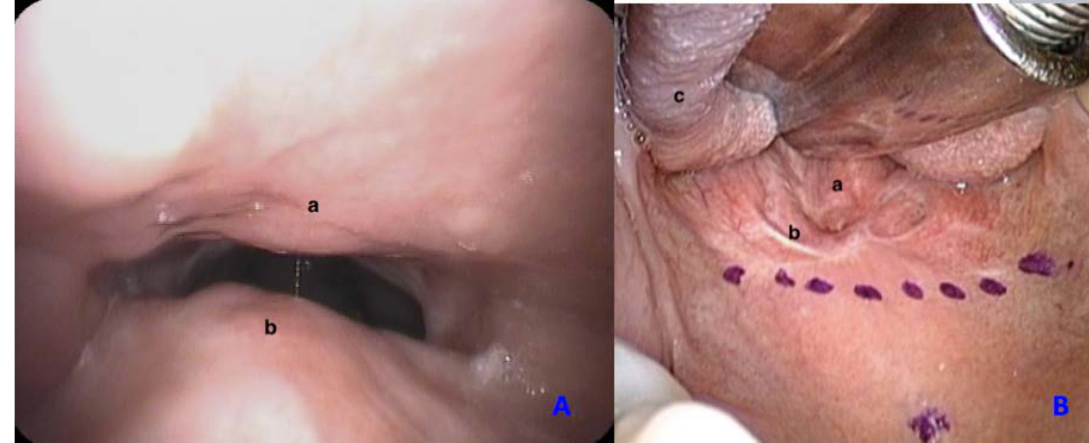
Figure 1. Pre-operative vision of nasopharyngeal stenosis from a nasopahryngeal ( A ) and oral ( B ) perspective. a—posterior pharyngeal wall, b—soft palate, c—tongue.